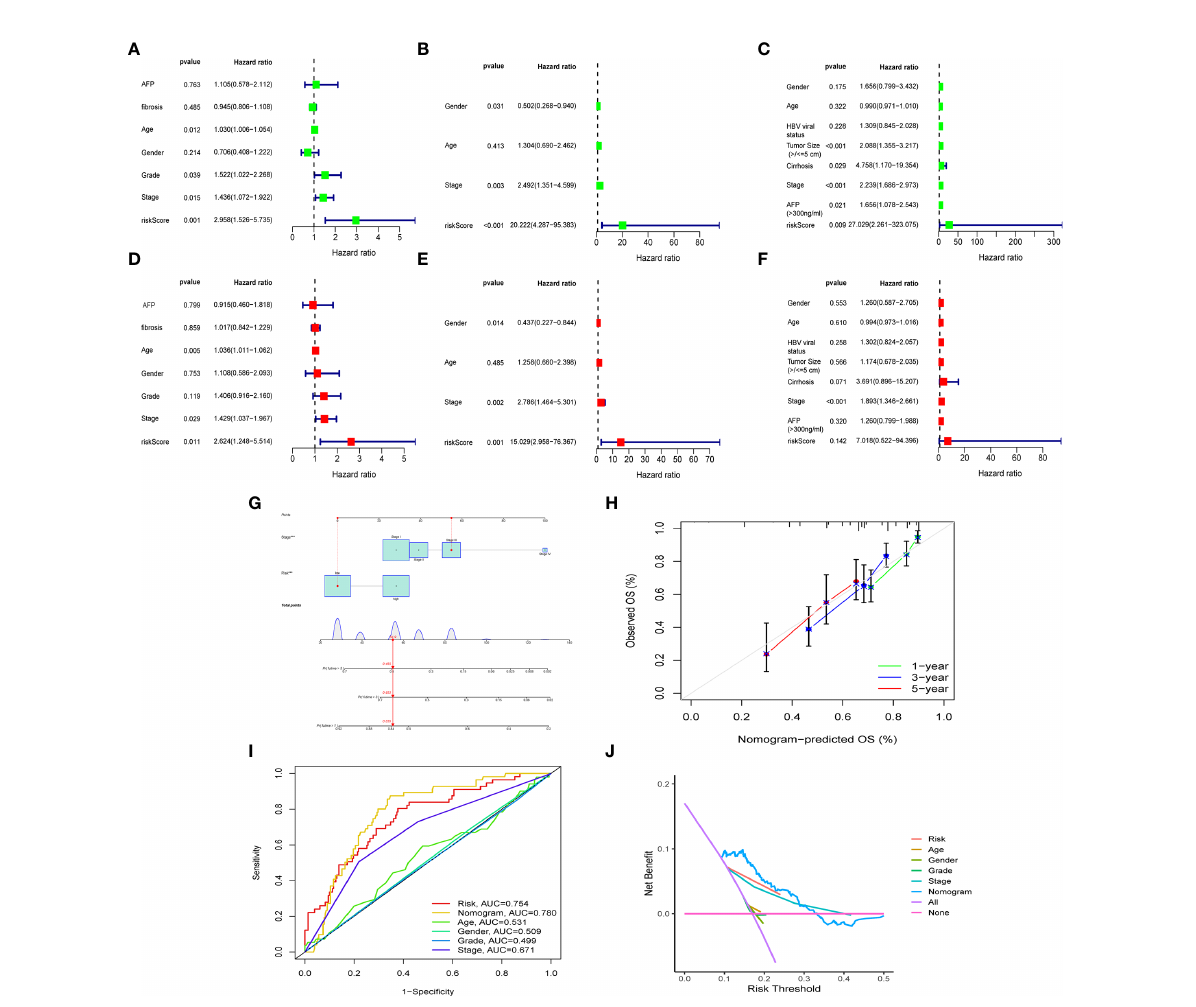
FIGURE 5 The construction of OS predictive nomogram for HCC patients. Results of univariate and multivariate Cox regression analysis of OS TCGA cohorts (A, D) , ICGC cohorts (B, E) and GEO cohorts (C, F) . Univariate Cox regression analysis to screen for OS-related factors (A-C) . Multivariate Cox regression analysis to screen for OS-related factors (D-F) . The nomogram is used for predicting 1-, 3-, and 5-year overall survival probability of HCC patients (G) . The calibration plots for predicting patient 1-, 3-, or 5-year OS (H) . AUC of clinical characteristics, risk score, and the risk score combined with tumor stage at 1-year OS (I) . DCA curves for two independent prognostic factors or a combination of them in OS prediction (J) . HCC, hepatocellular carcinoma; OS, overall survival; ROC, receiver operating characteristic curve; DCA, decision curve analysis; AUC, area under